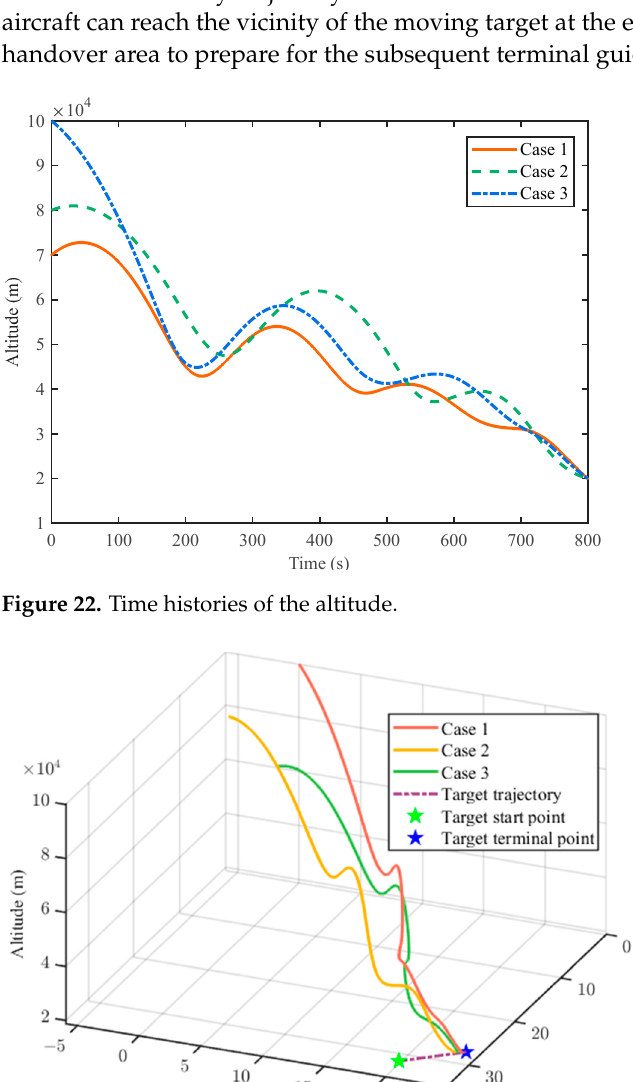
Figure 24. Time histories of the velocity. Figure 25. Velocity histories of the AOA.